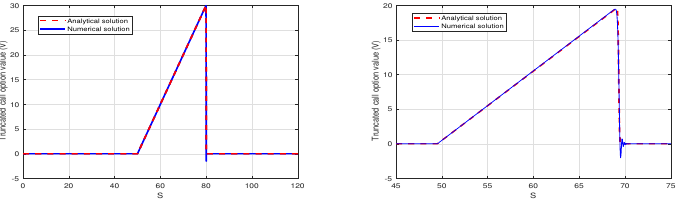
Figure 11. Poor performance of the MMADE scheme if the conditions in Theorem 1 are not satis- fied. Example with parameter values r = 0.07, σ = 0.001, a = − 1300, T = 0.01, U = 80, K = 50, L = 20, S max = 120, ∆ S = 0.01, ∆ t = 10 − 4 ( left ) and Example with parameter values r = 0.01, σ = 0.001, a = − 50, T = 1, U = 70, K = 50, L = 30, S max = 140, ∆ S = 0.05, ∆ t = 10 − 3 ( right